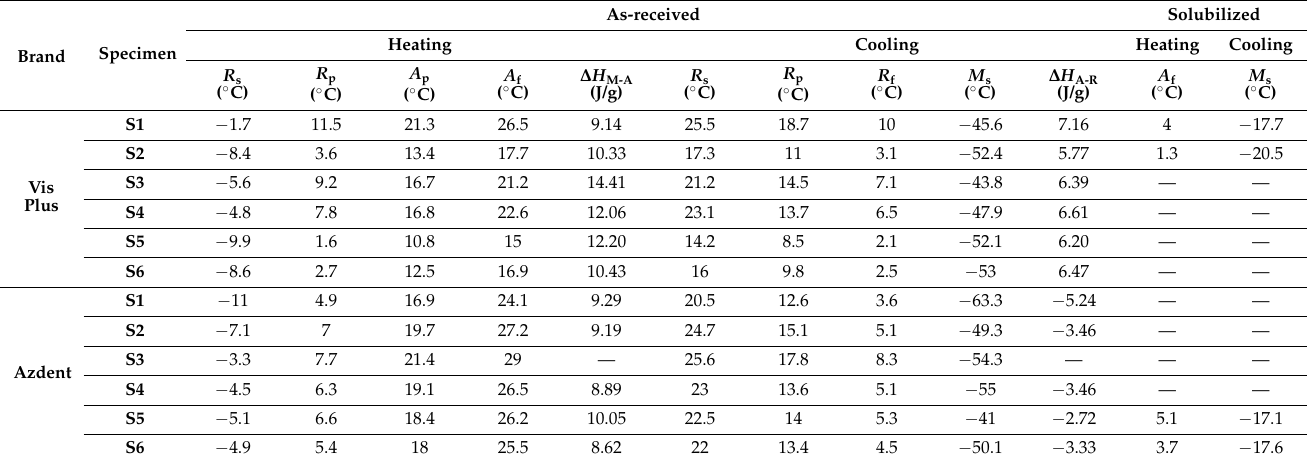
Table 4. Phase transition temperatures and transition enthalpy of as-received and solubilized NiTi products during cooling and heating ramp; s , p and f stand for the start, peak and finish points of rhombohedral (R), martensite (M) and austenite